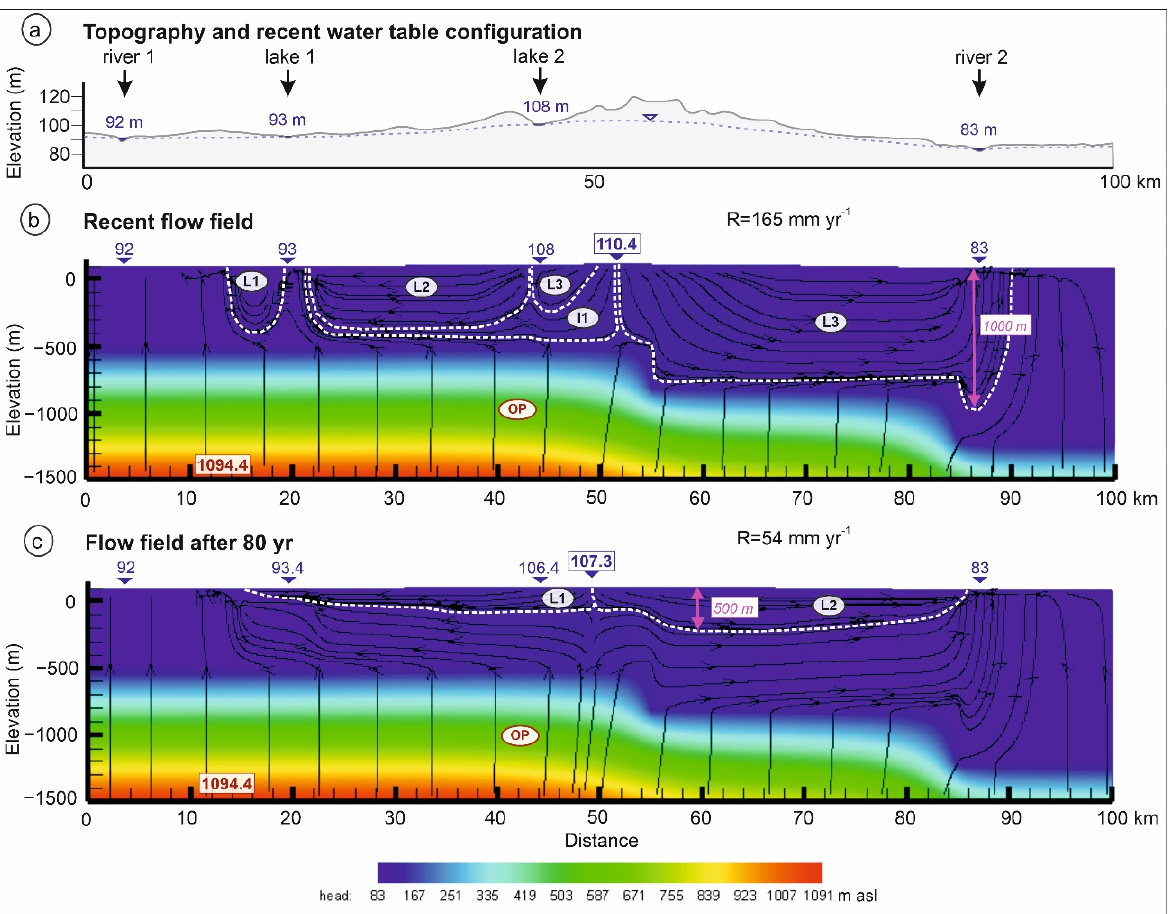
Figure 4. Results of the simulation of combined flow system with gravity-driven and overpressured flow showing ( a ) recent groundwater table configuration in relation to the topography, ( b ) the steady-state hydraulic head distribution and flow patterns generated by the recent groundwater table topography and upward overpressured flow and ( c ) the quasi-steady-state hydraulic head distribution and flow pattern after 80 yr obtained from transient simulation. Hydraulic head values are colour-shaded; groundwater flow directions are indicated by black arrows; dark blue numbers represent the surface water levels (m asl); dark blue bold number in rectangle represents the maximum hydraulic head along the water table (m asl); red bold number in rectangle showing hydraulic head maximum within the flow field (m asl); and dashed lines show the boundaries of different flow systems: L1, L2, L3, L4 are local, I1 is intermediate, R1, R1 ′ , R2, R2 ′ are regional flow systems, OP represents overpressured upward flow domain. Purple arrows with number in rectangle showing the maximum penetration depth of the upper gravity-driven flow system. „R” is actual recharge at the corresponding time. Distances between streamlines are not proportional to water flux. Cross-section has 13× vertical exaggeration.